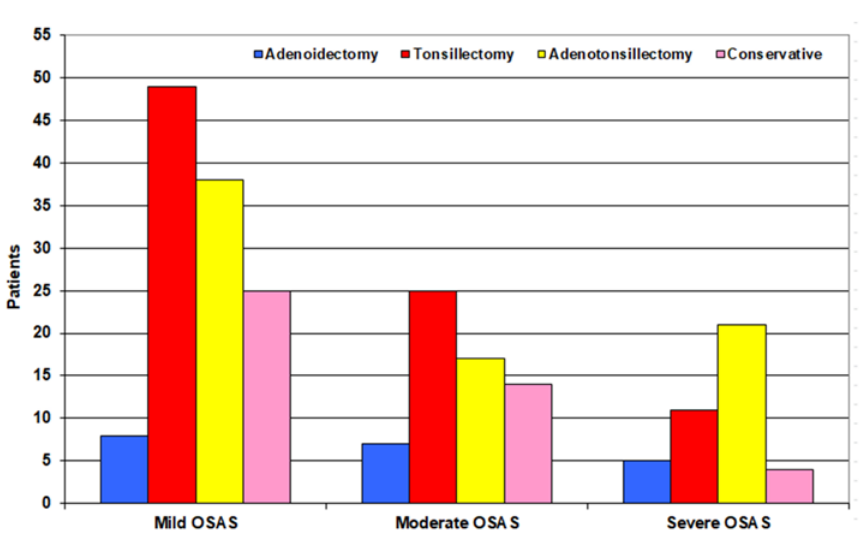
Figure 2. Patient distribution according to the surgical decision. At the end of the follow-up, 33 patients had residual OSAS, with a significantly higher incidence of residual OSAS in patients with severe OSAS in comparison to its inci- dence among patients with mild OSAS ( p 2 = 0.001). Additionally, there was a significant difference between patients with mild and moderate OSA ( p 1 = 0.04), with a non-signifi- cantly ( p 3 = 0.092) higher incidence of residual OSAS among patients with severe OSAS than in patients with moderate OSAS. The pediatric sleep questionnaire baseline score was significantly higher in patients with severe OSAS compared to patients with mild ( p 2 = 0.002) and moderate OSA ( p 3 = 0.005), with a non-significantly ( p 1 = 0.692) higher score in patients with moderate OSAS compared to patients with mild OSAS. At the end of the follow-up, the mean score was significantly ( p 4 < 0.001) decreased in all patients in com- parison to their baseline score. However, the score determined at the end of the follow-up was still significantly higher in patients who had severe OSAS in comparison to those who had mild ( p 1 = 0.002) and moderate ( p 2 = 0.047) OSAS, with a non-significantly ( p 1 = 0.192) higher score in patients with moderate OSAS in comparison to patients with mild OSAS (Table 2). Regarding cognitive function, the baseline NESPY score was significantly higher in patients with mild OSAS in comparison to patients with moderate ( p 1 = 0.004) and se- vere OSAS ( p 1 = 0.001), with a non-significantly ( p 2 = 0.096) higher NESPY score in pa- tients with severe OSAS in comparison to patients with moderate OSAS. At the end of the follow-up, all patients showed a significantly ( p 3 < 0.001) higher NESPY score in compar- ison to their baseline score. At the end of the follow-up, the NESPY score of patients with severe OSAS was significantly ( p 1 = 0.030) higher in patients with mild OSAS in compar- ison to patients with severe OSAS but was non-significantly ( p 1 = 0.137) higher than the NESPY score of patients with moderate OSAS, while patients with moderate OSAS showed a non-significant ( p 2 = 0.798) higher NESPY score in comparison to patients with severe OSAS. The NESPY score at the end of the follow-up was significantly higher in all patients in comparison to their baseline score ( p 4 < 0.001). Differentially, at the end of the follow-up, 43 patients (19.2%) showed no change in NESPY score, while 181 patients (80.8%) showed an improved NESPY score, with a non-significantly higher frequency of patients showing an improved NESPY score among patients with severe OSAS in com- parison to patients with mild or moderate OSAS. However, the percentage of improve- ment of the NESPY score was significantly higher in patients with severe OSAS in com- parison to those with mild ( p 2 < 0.001) or moderate OSAS ( p 3 = 0.002), with a significantly ( p 1 = 0.002) higher percentage of improvement in patients with moderate OSAS compared to patients with mild OSAS (Table 2).